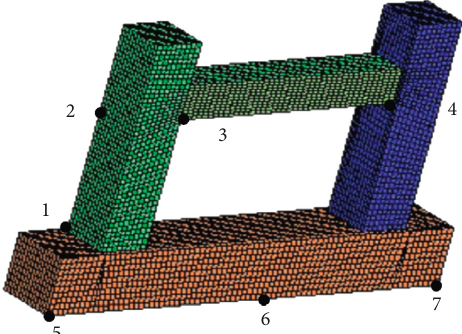
Figure 2: Meshing of the concrete